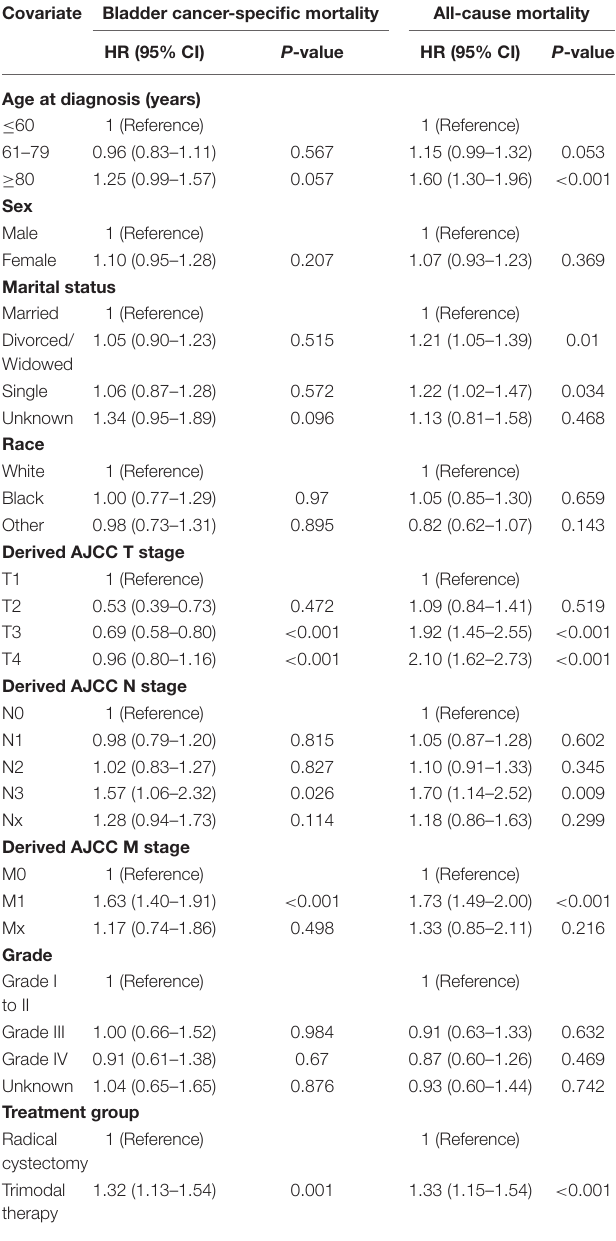
TABLE 3 | Proportional hazards regression model for the all-cause mortality and bladder cancer-specific mortality according to treatment type.